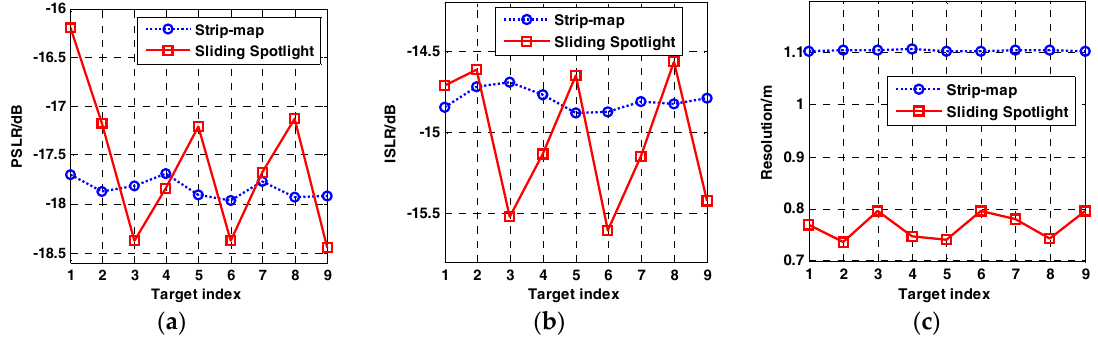
Figure 15. Distribution of focusing performances for SAR data with intensive motion error. ( a – c ) are the distributions of PSLR, ISLR, and resolution, respectively. The blue dashed line and red one are the results of strip ‐ map and sliding spotlight, respectively.